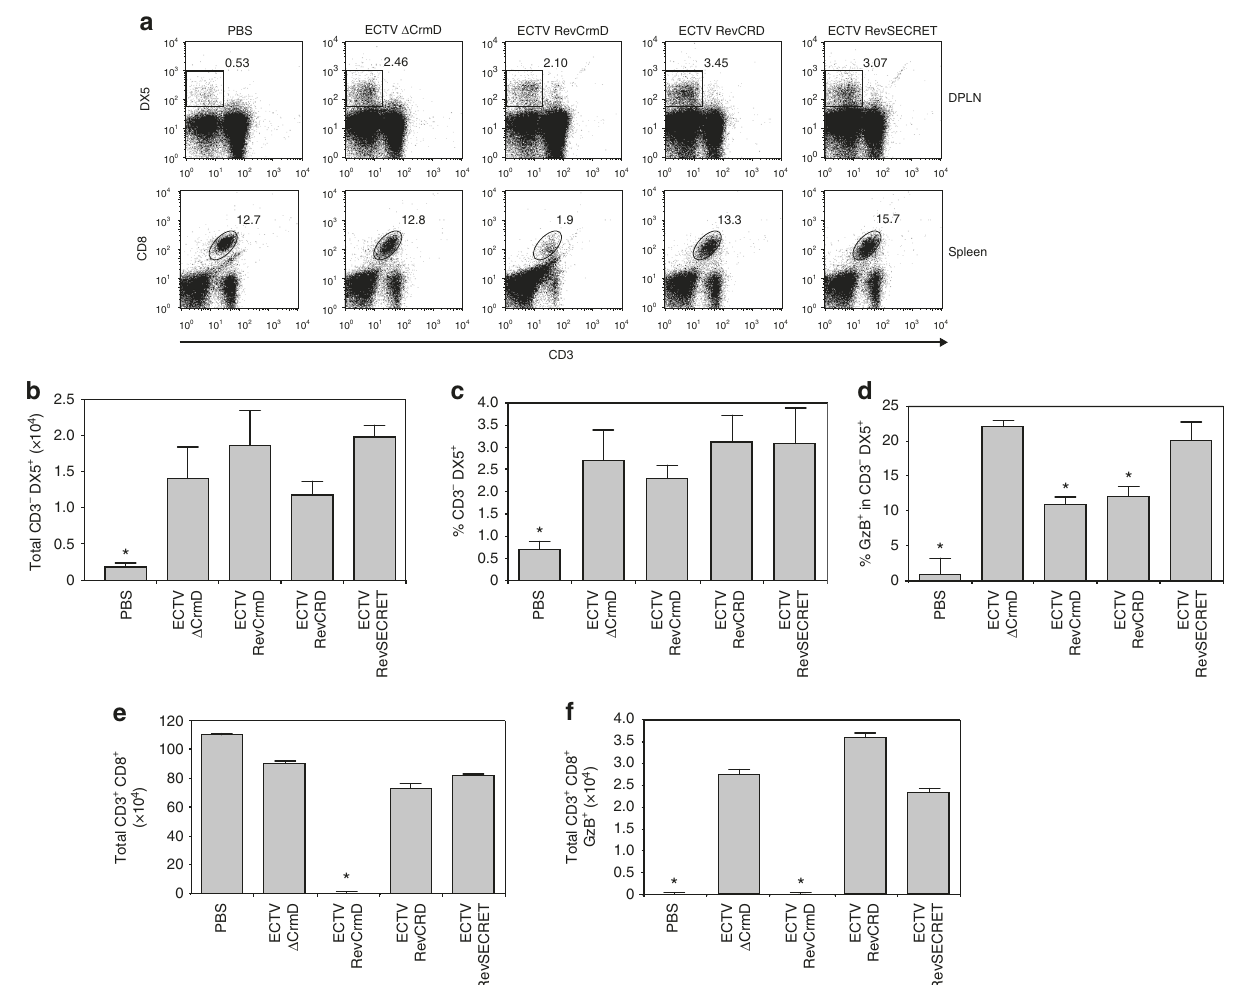
Fig. 8 Inhibition of TNF activity in vivo impairs NK cell activation in response to ECTV infection. Cells from DPLN ( a – d ) harvested at 2 dpi or from spleens ( a, e, f ) collected at 7 dpi from PBS-inoculated BALB/c mice or mice infected with 10 5 pfu of the indicated viruses were analyzed by fl ow cytometry using conjugated anti-CD3, anti-CD8, anti-DX5 and anti-granzyme B (GzB) antibodies. In a , representative dot plots of the staining of NK cells (CD3 – DX5 + ; top panel) and CD8 T cells (CD3 + CD8 + ; bottom panel) isolated from DPLN or spleen, respectively, are shown. Number inside each graph indicates the % of cells inside the depicted gates. In b and c , a quanti fi cation of the total number and % of NK cells, respectively, is presented. The % of NK cells expressing granzyme B in each group is quanti fi ed in d . In e and f , a quanti fi cation of the total number of CD8 T cells and granzyme B-expressing CD8 T cells detected for each group is shown. The number of events positively stained with the corresponding isotype control antibodies (isotype DX5, 0.15% positives; isotype CD8, 1.3% positives; isotype granzyme B, 0.02% and 0.03% positives in DPLN and spleen, respectively) were subtracted from each sample for the quanti fi cation analyses. Data are mean + / − SD from one experiment representative of three independent experiments with 4 – 5 animals per group. Statistically signi fi cant groups are indicated (asterisks p < 0.05, ANOVA with Bonferroni multiple comparison